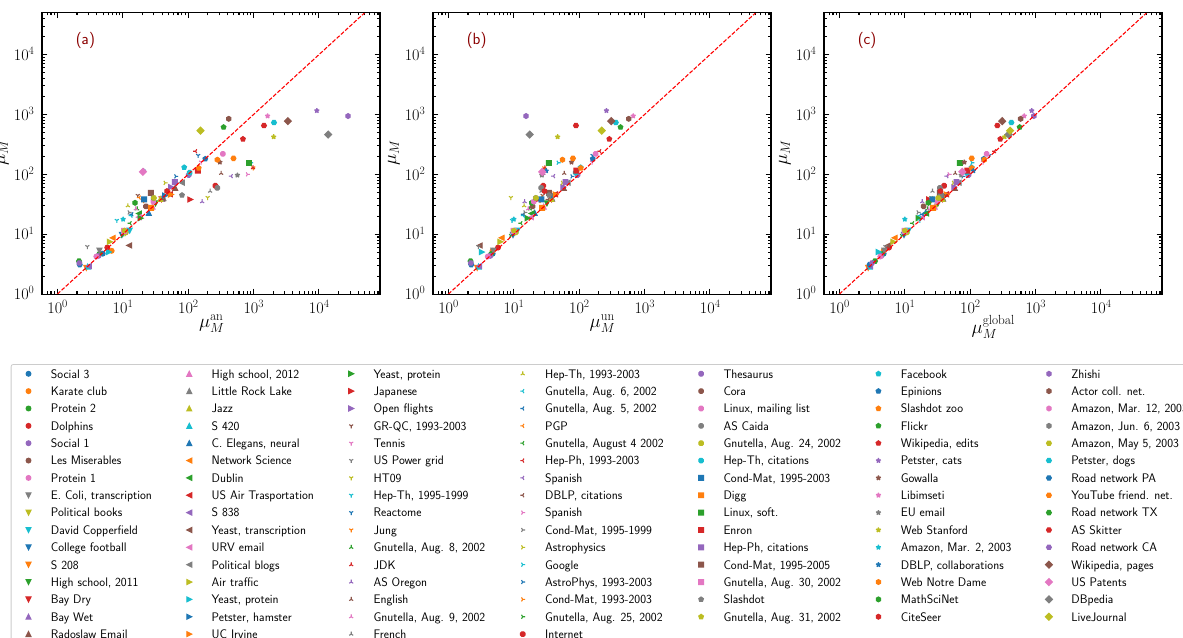
Figure 3. Test of theoretical approaches for real-world networks. LEV of the NB matrix, µ M , as a function of the theoretical predictions µ un M [Eq. (8a)] µ an M [Eq. (9b)], and µ networks described in Supplementary Table Method “Largest non-backtracking eigenvalue of characteristic subgraphs” section) shows that this is true unless ( N / ) 1 / 2 . Only in this case an integrated hub has an effect and leads to a PEV significantly larger than the K k � � ≫ PEV of the original network and scaling as However, it is possible that other types of subgraphs play for the NB centrality the same role that star graphs